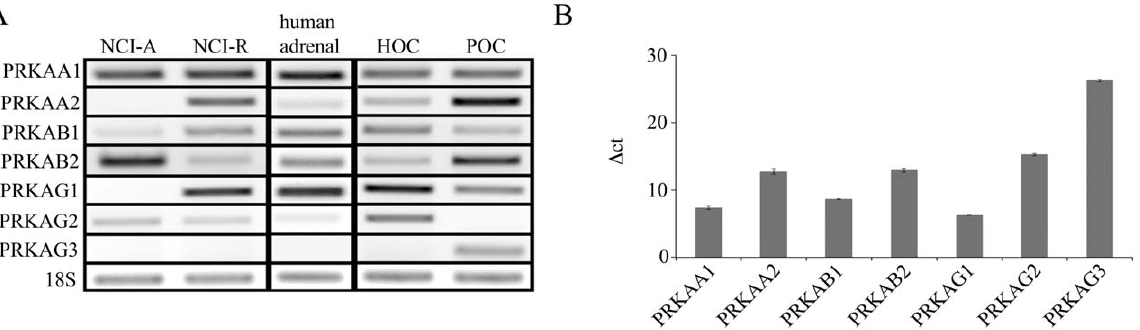
Figure 1. Expression pattern of the subunits of AMPK (PRKA) in steroidogenic tissues. RNA was extracted from human adrenal NCI-H295 cells, adult human adrenal tissue and human as well as porcine primary ovarian cell culture. A, semiquantitative RT-PCR (30 cycles) was performed on 100 ng of reverse-transcribed total RNA using specific primers and PCR products were separated on a 1.5% agarose gel and visualized with ethidium bromide. Shown is a representative gel of three independent experiments. B, QRT-PCR was performed on 50 ng cDNA obtained from NCI-H295R cells using ABsolute QPCR SYBR Green Mix. Data represent calculations of two independent experiments where 18S rRNA served as internal control.